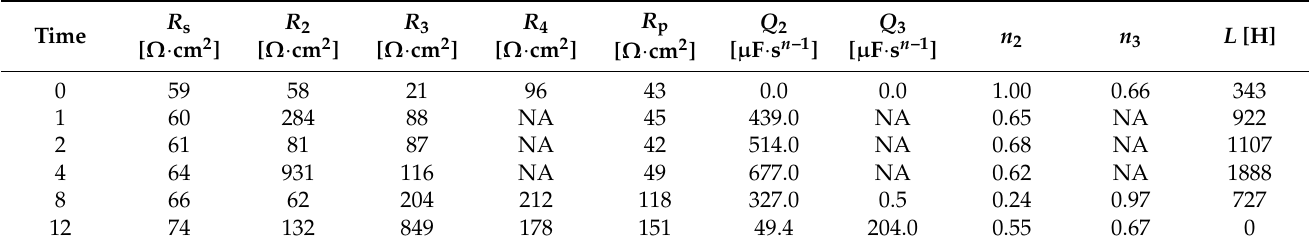
Table 2. Polarization resistance of pure Mg compacted at 500 MPa/RT.